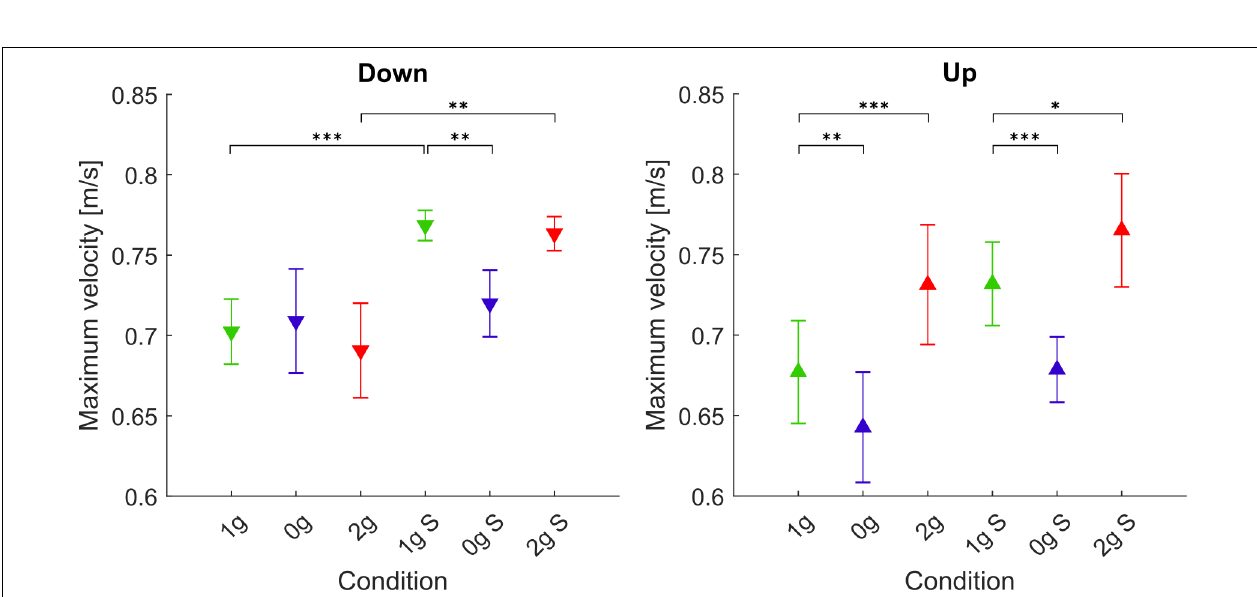
FIGURE 5 | Maximum velocities. Downward-pointing triangles denote mean values for downward movements, upward-pointing triangles denote mean values for upward movements, the whiskers denote the standard error of the mean. Green represents normogravity, blue represents microgravity and red represents hypergravity conditions, (1g, 0g, 2g) denote in-flight gravitational conditions, (1g S, 0g S, 2g S) denote simulated gravitational conditions. ∗ p < 0.05, ∗∗ p < 0.01, ∗∗∗ p < 0.001.